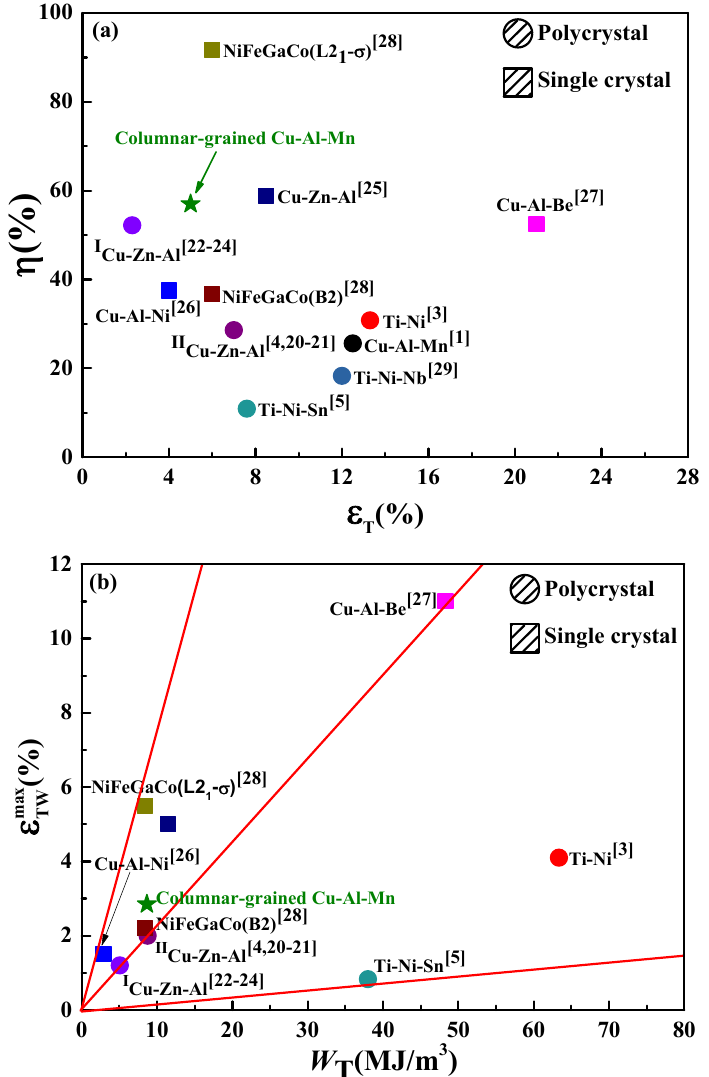
Figure 9. ( a ) Comparisons of η vs. ε T and ( b ) ε max vs. W T for different SMAs.